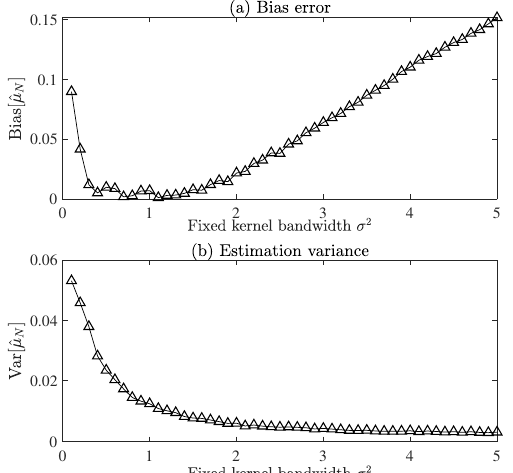
Figure 1. Bias error and estimation variance for various fixed kernel bandwidth σ 2 in a general mean-shift